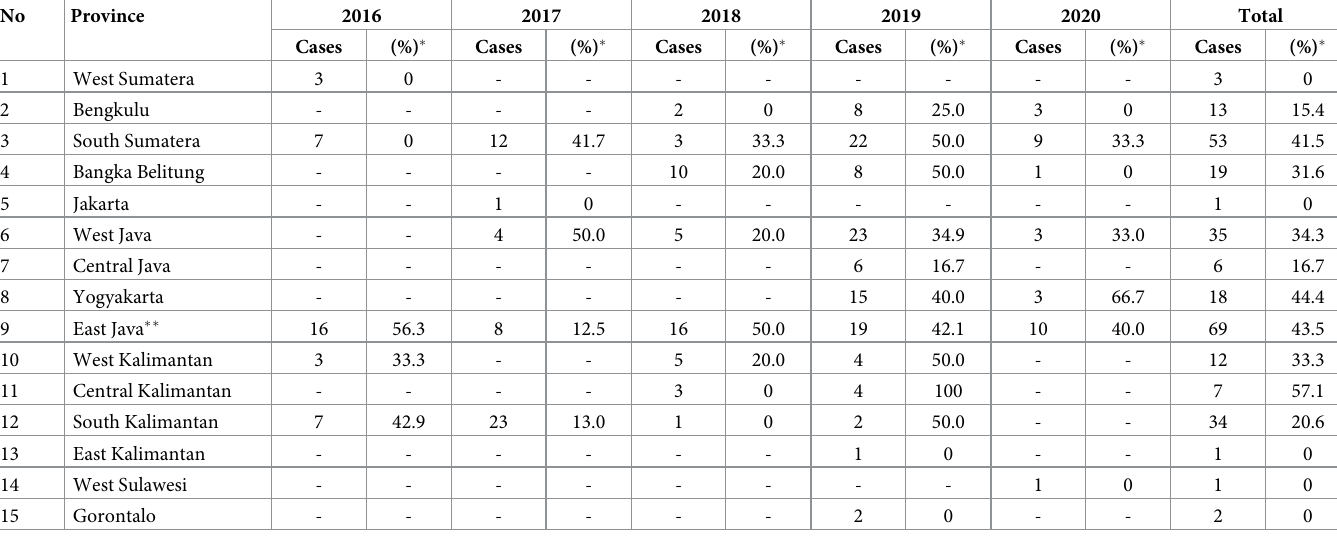
Table 1. Distribution of clinical and confirmed cases of pertussis in Indonesia during 2016–2020 by provinces. No